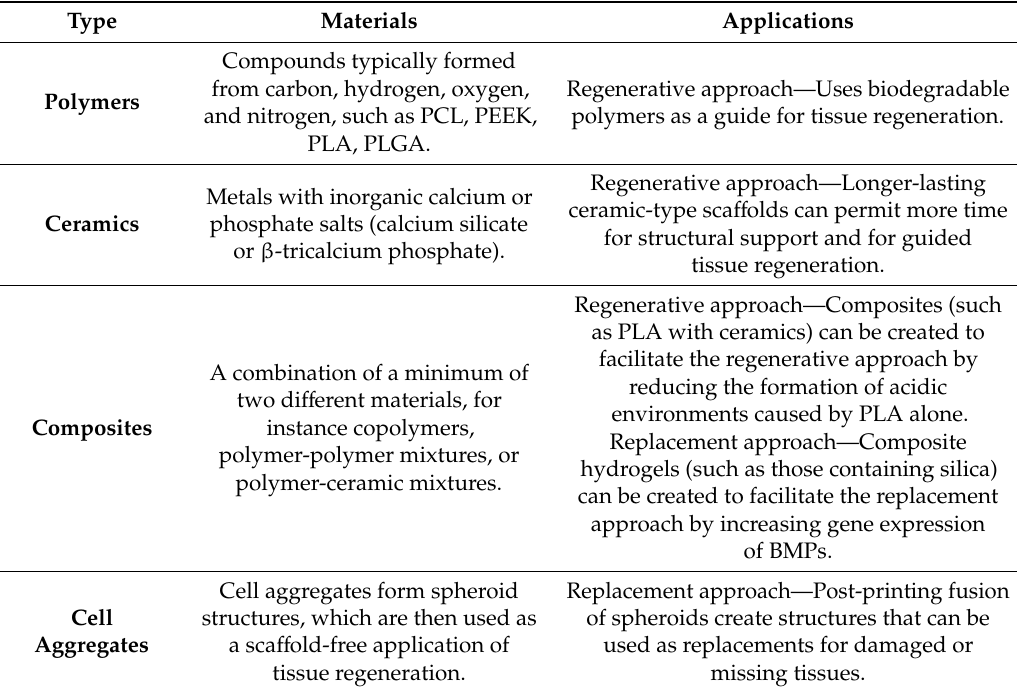
Table 2. Summary of 3D printing materials for tissue